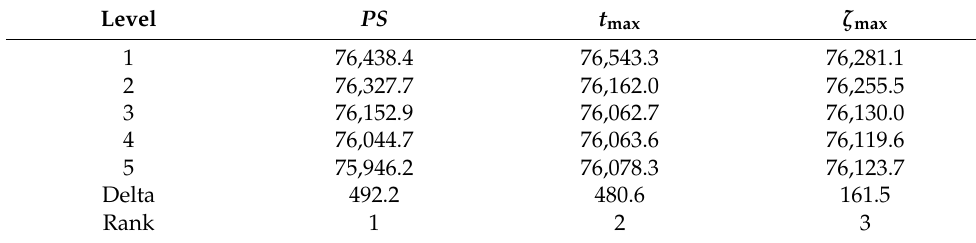
Table 3. Response value and significance